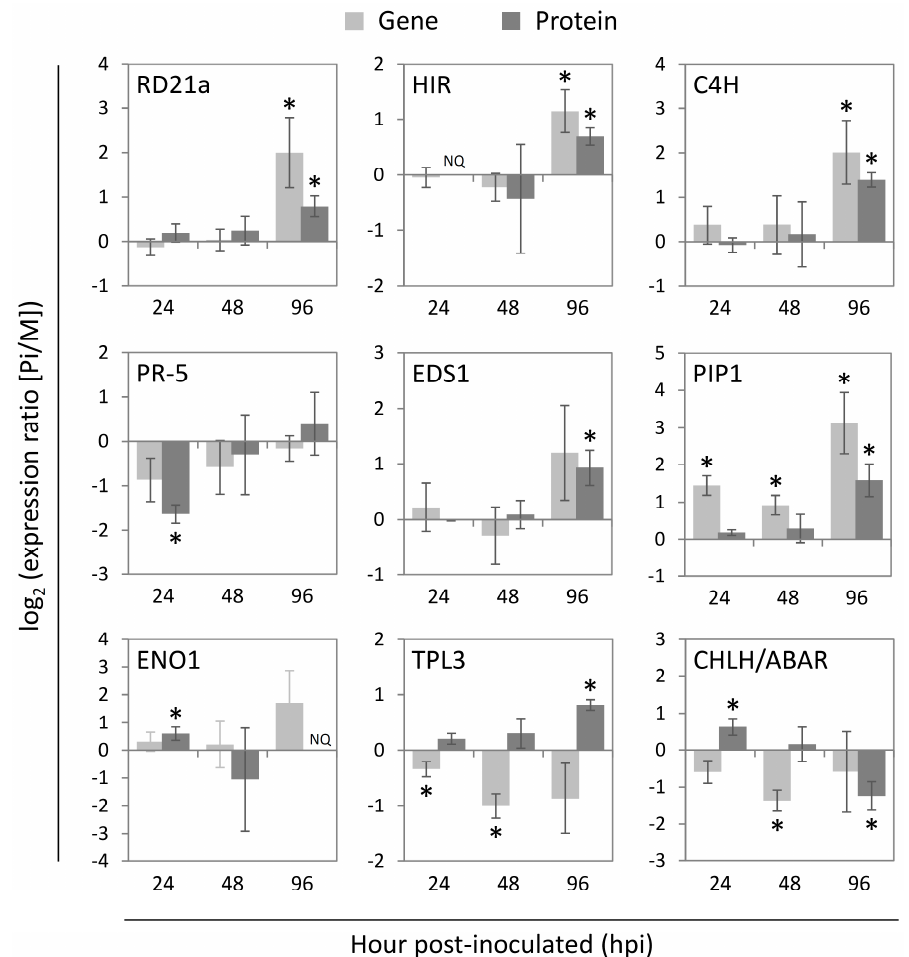
Figure 4. Levels of tomato transcripts encoding proteins that were differentially regulated in response to different pathogenesis stages of P. infestans . The transcript levels of the selected P. infestans -regulated proteins (RD21a, HIR, C4H, PR-5, EDS1, PIP1, ENO1, TPL3, and CHLH/ABAR) in tomato were determined by qRT-PCR in the same samples prepared for the proteomics analysis in this study. The mean values from three biological repeats are shown (n = 3). All statistically significant differences between the P. infestans (Pi) and mock (M)-treated samples are indicated with asterisks (*, p < 0.05), based on the Student’s t -test using the log 2 -ratio of the gene or protein expression levels between these two conditions. The internal control Ubi-3 gene was used for normalization. Error bars are means ± SD. NQ, non-quantifiable as the protein quantification was only measurable in one or two biological replicates.